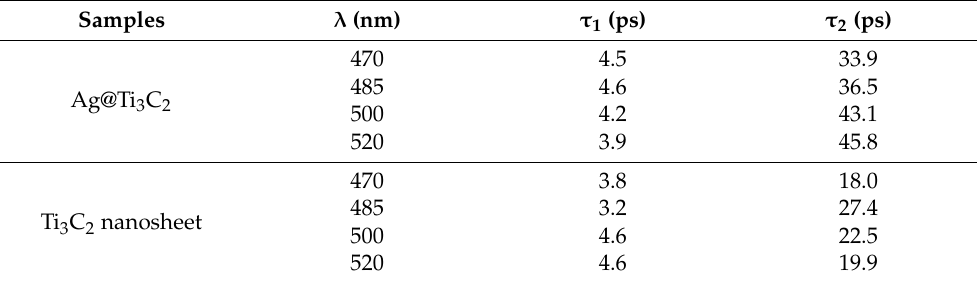
Table 2. Carrier dynamics parameters of the Ti 3 C 2 nanosheet.